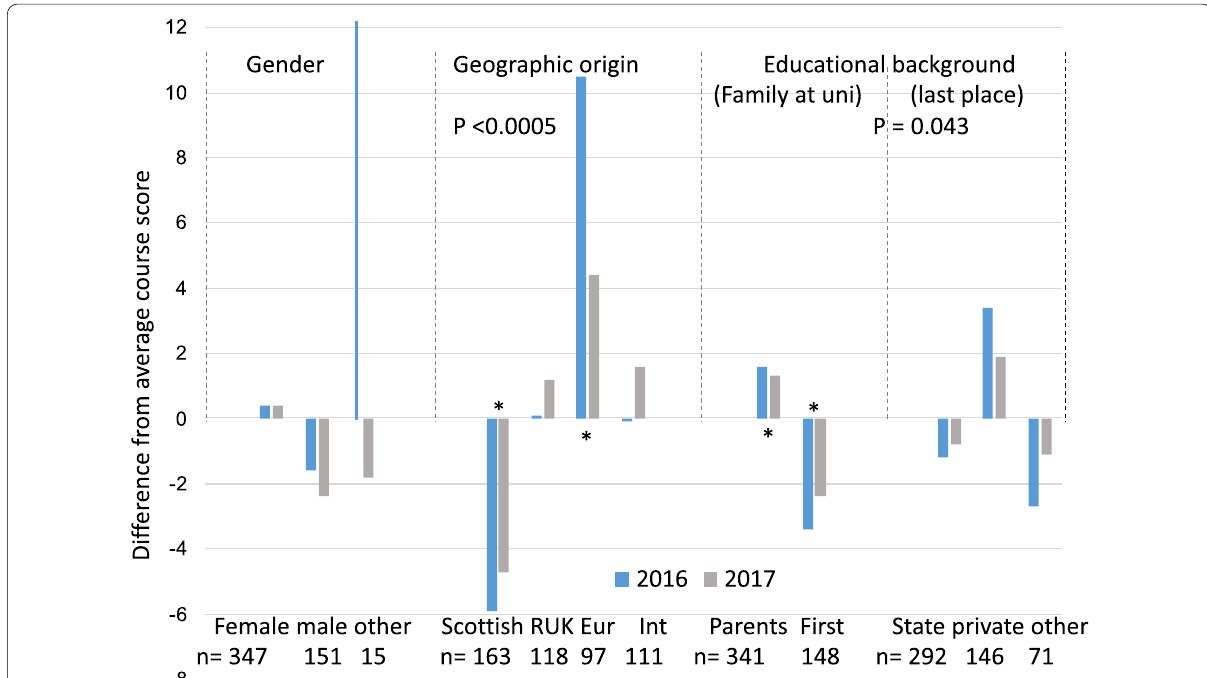
Fig. 6 Variations in course score within demographic groups. Relative course scores within four demographic categories for each of 2 years (2016 and 2017) are shown as differences between the average score for each group and for the whole class. RUK rest of UK (not Scottish), Eur rest of Europe and Int international (all other parts of the world). Parents parents attended university, First student is first in family to attend university. State state school, private private school. In 2016 there were only two ‘gender other’ students giving a high average score of 78%, indicated by a thin blue line. *Significant difference (P < 0.05) between course scores for this sub-group and all other sub-groups within the same category